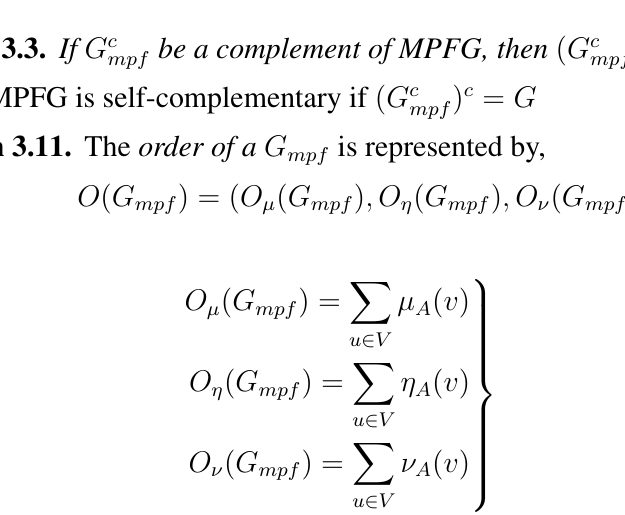
Figure 2: Complement of Mixed Picture Fuzzy